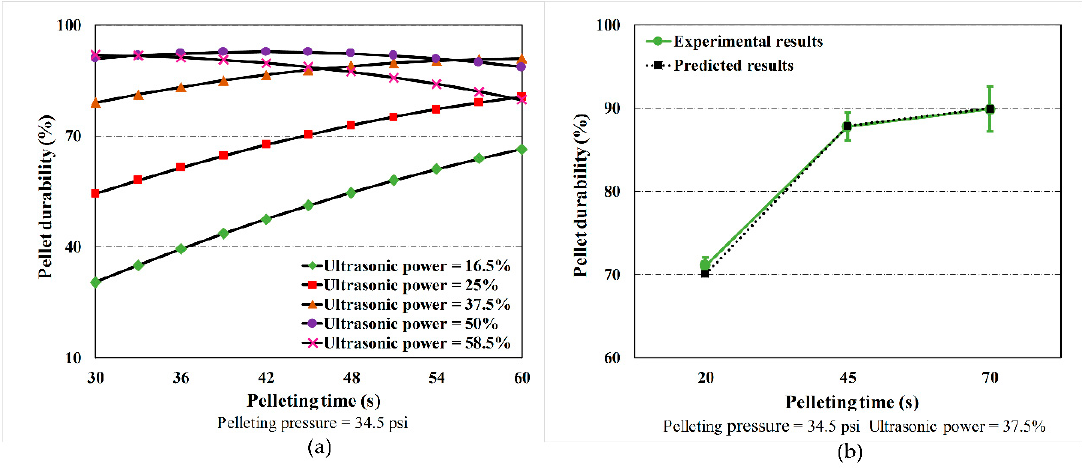
Figure 5. The effects of pelleting time on pellet durability. ( a ) The predicted pellet durability in relation to the pelleting time at different levels of ultrasonic power (ranging from 16.5% to 58.5%) when the pelleting pressure was set to 34.5 psi (237,869.1 Pa) and the pelleting time increased from 30 s to 60 s. ( b ) For pellet durability, the comparison between the model results and experimental results at various levels of pelleting time (mean value ± SD).